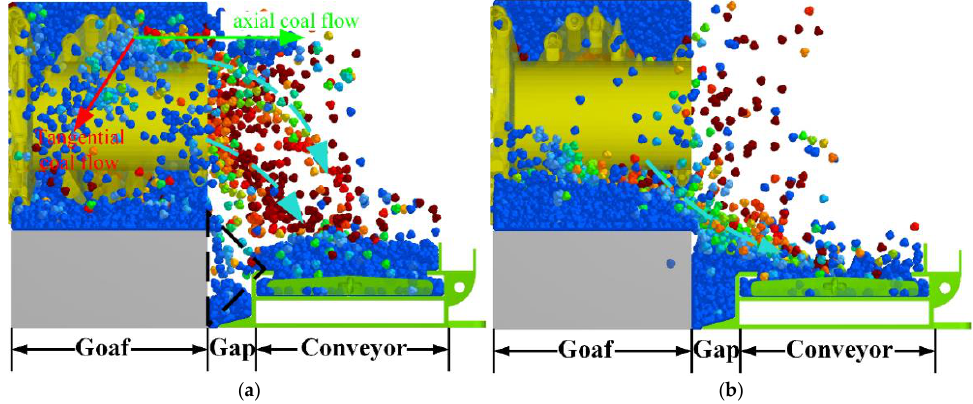
Figure 22. The comparison of coal-loading process in different loading modes: ( a ) ejection mode; ( b ) pushing mode.